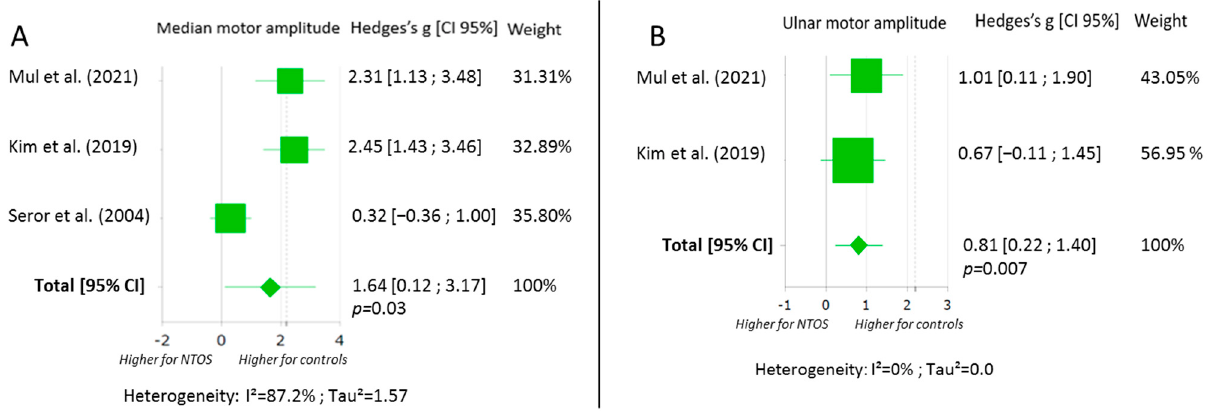
Figure 3. Forest plots of the motor nerve conduction studies for median ( A ) and ulnar ( B ) nerves [28,29,32]. Abbreviations: CI: confidence interval; NTOS: neurogenic thoracic outlet syndrome.